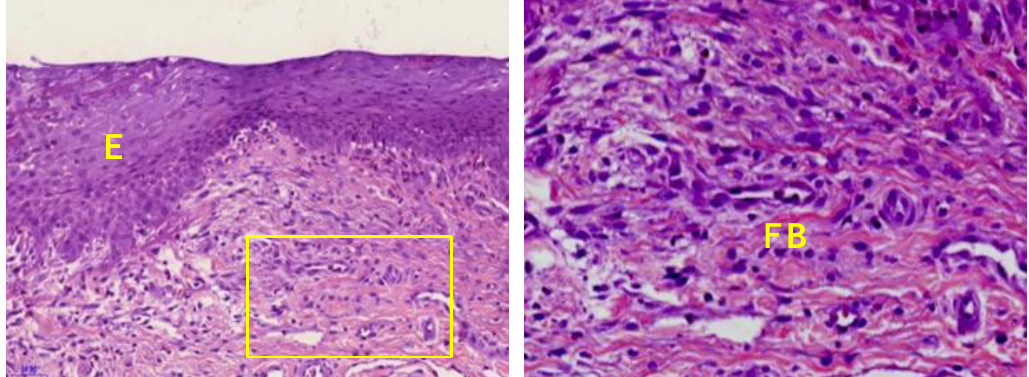
FF Figure 1: Histopathological findings belong to apparently normal gingiva (control group) in rabbit showing normal histology of dentogingival area epithelial (E), fibrous connective tissue and fibroblasts (FB). H&E x20, x40.